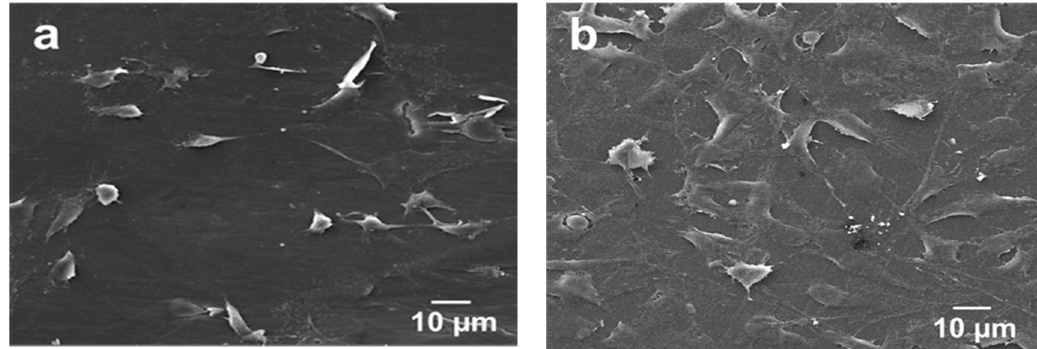
Figure 24. SEM images showing the adhesion of murine MC3T3-E1 pre-osteoblasts on PEEK/3.0 wt% MWNT for ( a ) two and ( b ) four days. Reproduced from [63] with permission of MDPI.